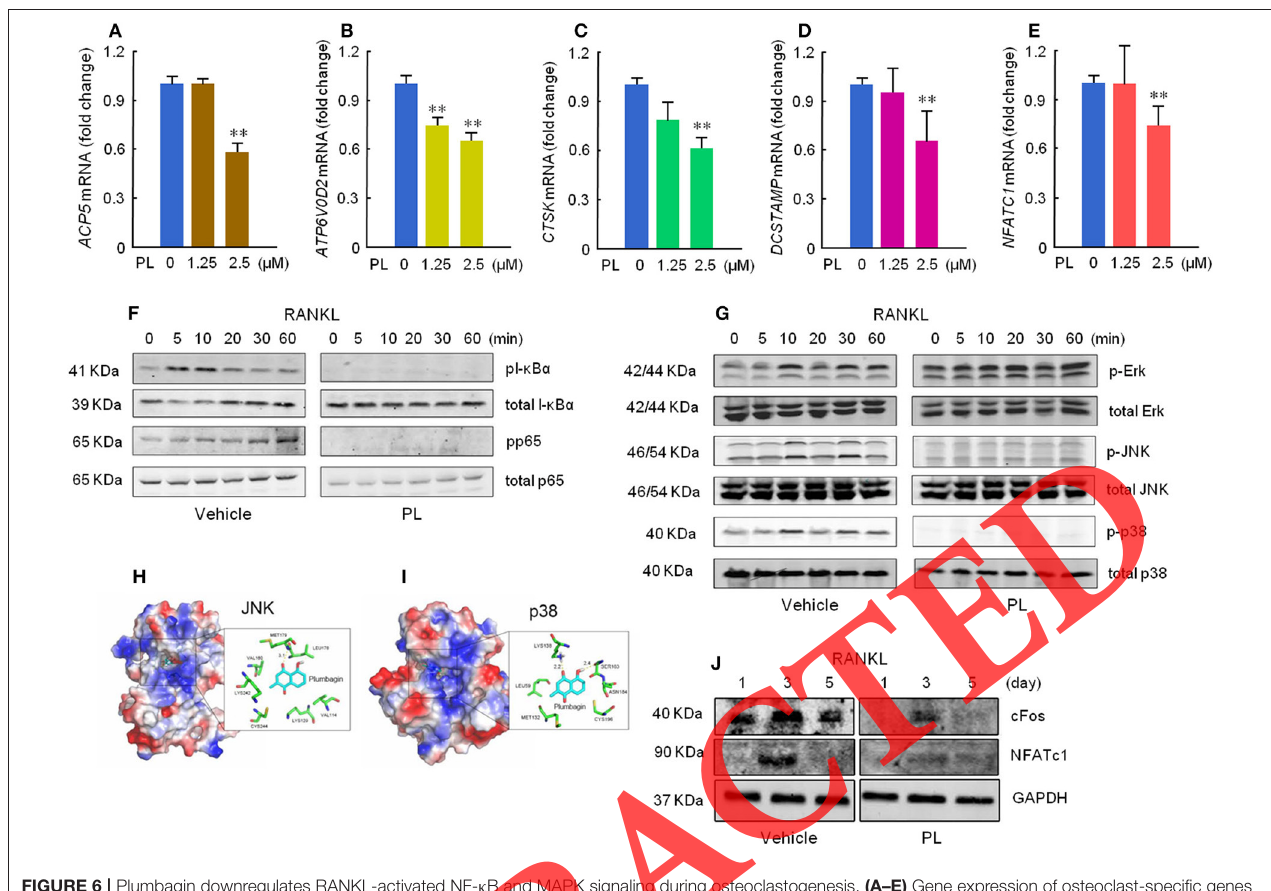
FIGURE 6 | Plumbagin downregulates RANKL-activated NF- κ B and MAPK signaling during osteoclastogenesis. (A–E) Gene expression of osteoclast-specific genes ( ACP5 , ATP6V0D2 , CTSK , DCSTAMP, and NFATc-1 ) as assessed by qRT-PCR of RAW264.7 cells under RANKL/M-CSF stimulation with or without plumbagin (1.25–5 µ M) for 24h. (F) Protein level of NF- κ B signaling in RAW264.7 cells treated with RANKL and plumbagin for up to 60min evaluated by Western blotting. (G) Protein level of MAPK signaling in RAW264.7 cells treated with RANKL and plumbagin for up to 60min evaluated by Western blotting. (H,I) The potential binding sites of plumbagin against JNK and P38 kinase displayed by molecular docking assay. (J) Downstream osteoclastic protein (c-fos and NFATc-1) levels in RAW264.7 cells treated with RANKL and plumbagin for up to 5d evaluated by Western blotting. Quantitative results are presented as mean ± SEM, and n = 3/group.** P < 0.01 vs. plumbagin 0 µ M